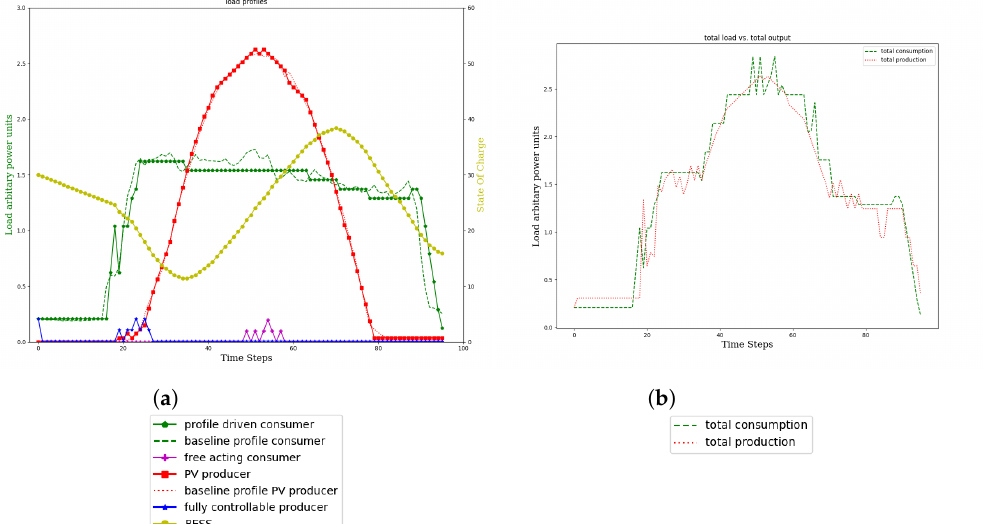
Figure 14. Evaluation on day 1, with the generalised trained agents. ( a ) Agent load curves and profiles. ( b ) Load